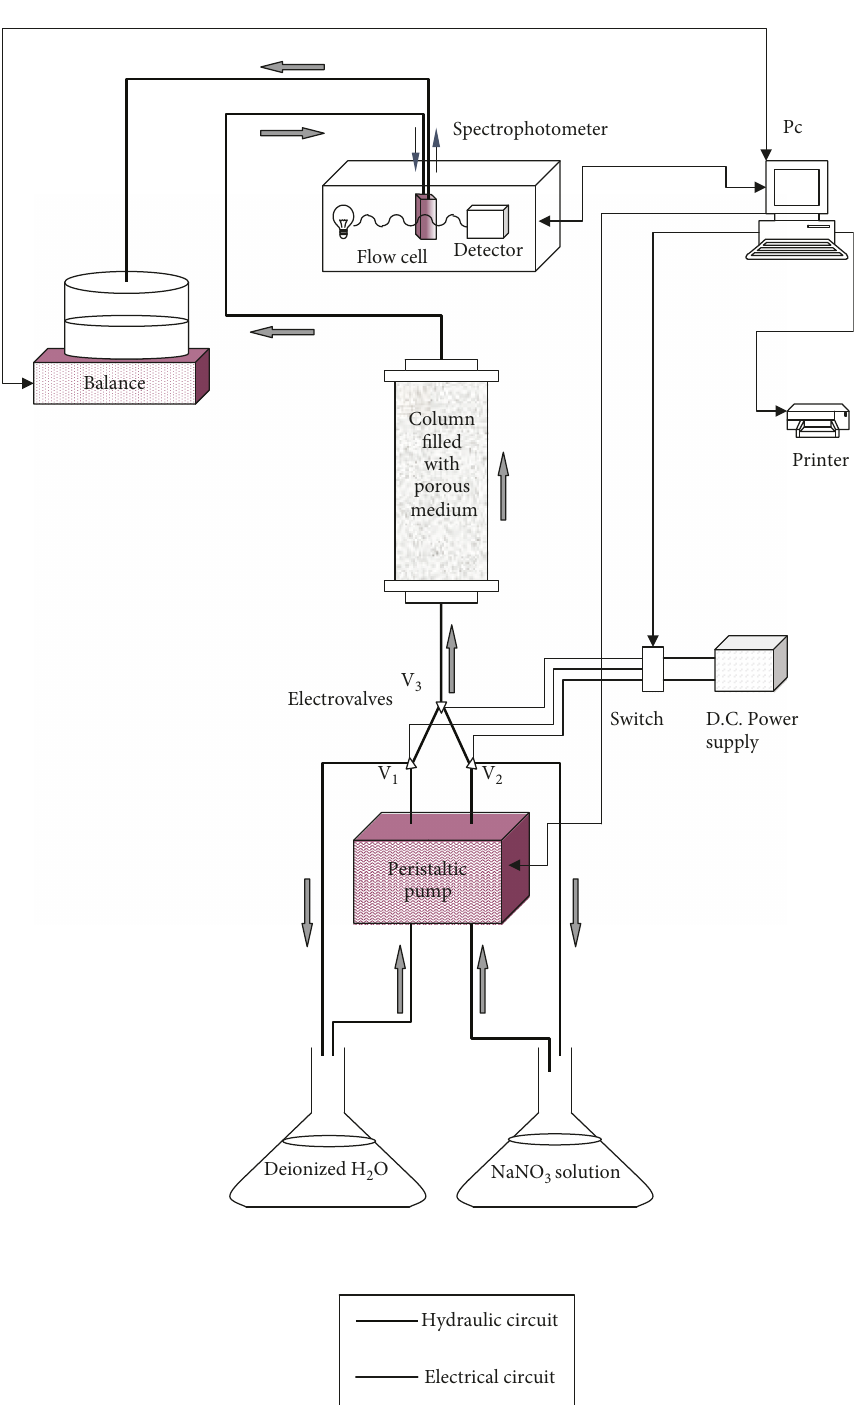
Figure 1: Scheme of the experimental setup (Contaminant Transport and Nuclear Safeguard Laboratory of the Politecnico di